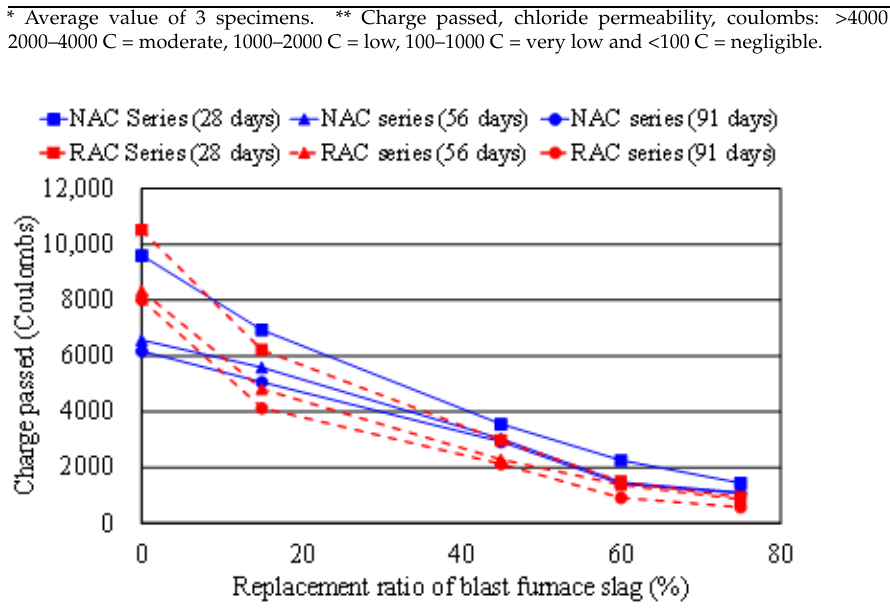
Figure 7. Total charge passed vs. BFS content of concrete.